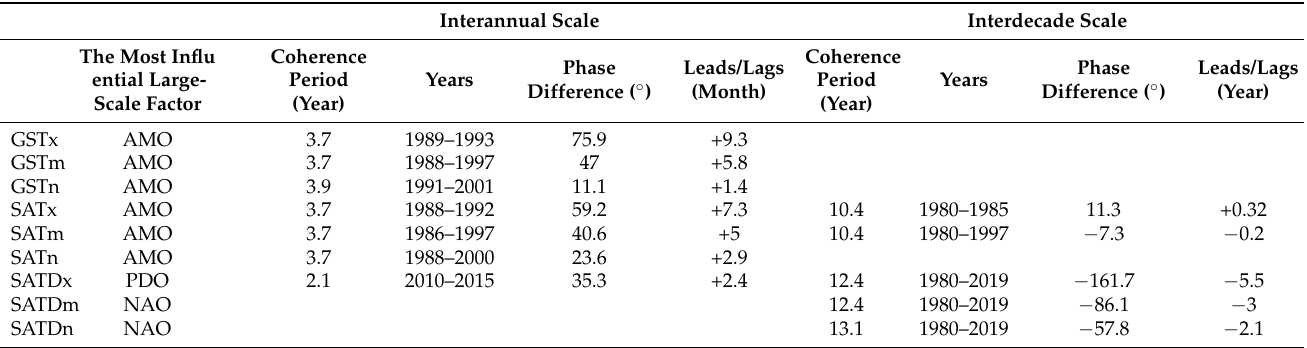
Table 9. Main results obtained by WTC for strongest relationships between monthly abnormal aver- aged GST-, SAT- and SATD-related indexes and the most influential large-scale index in Southwest China from 1980 to 2019.